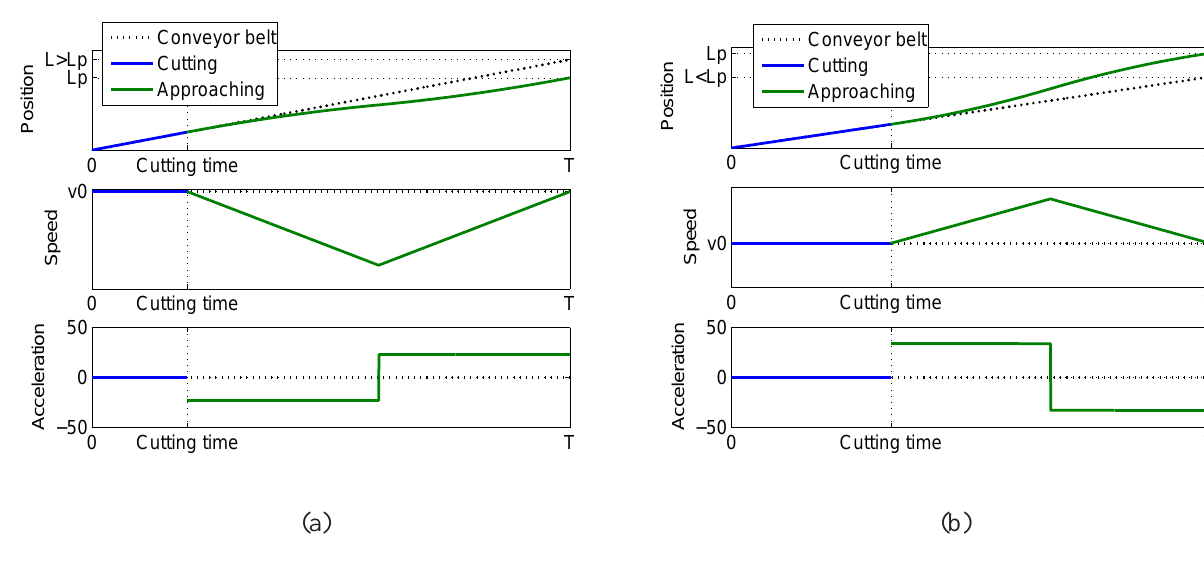
Figure 5. Motion sequence of the sealing process ( L P ≷ L 0